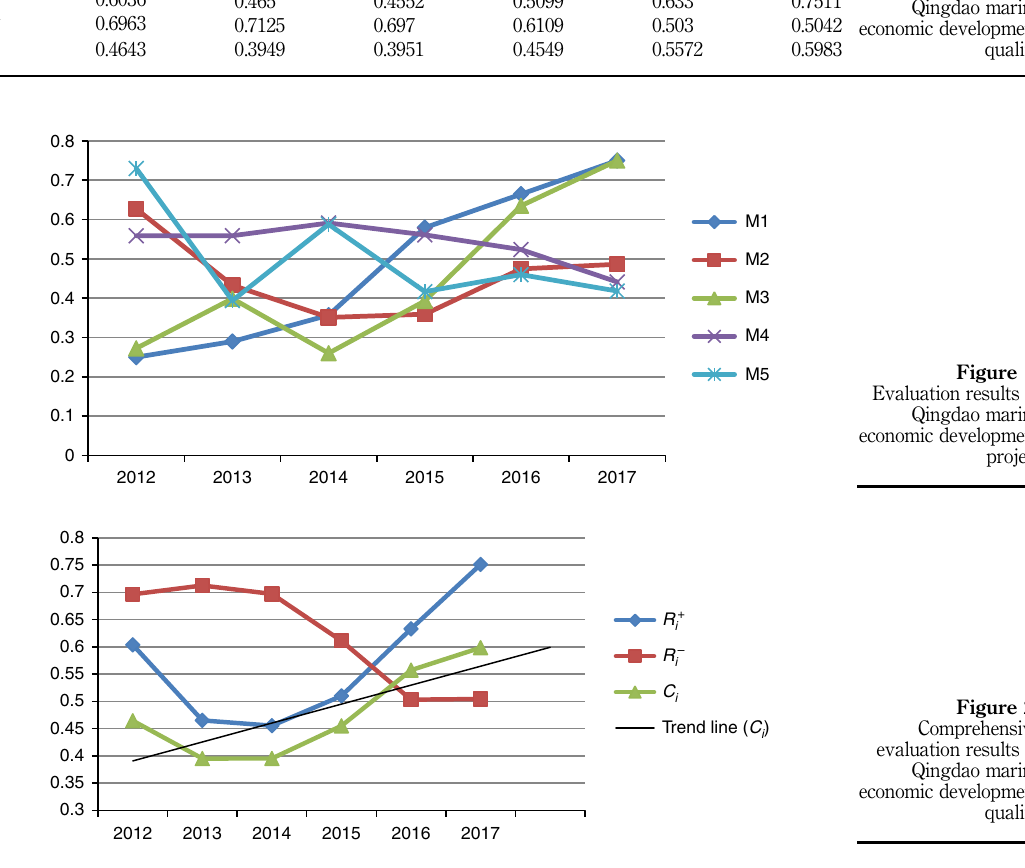
Figure 2. Comprehensive evaluation results of Qingdao marine economic development quality